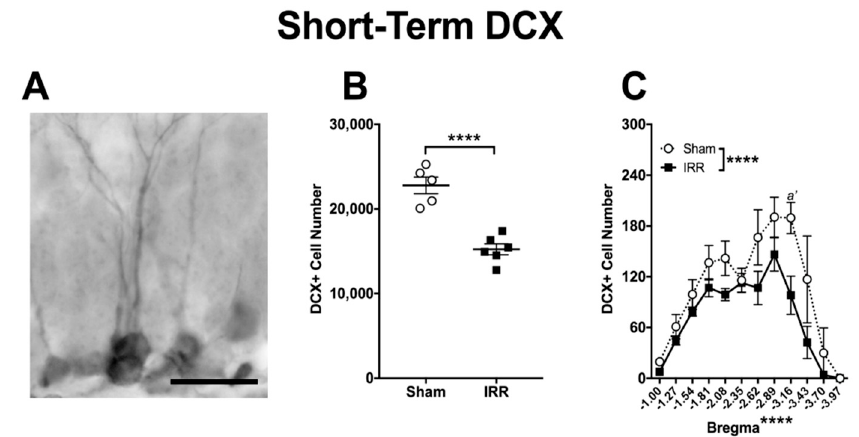
Figure 5. 24-h post-irradiation, whole-body exposure to 12 C irradiation reduced the number of DG GCL DCX+ cells relative to Sham treatment. ( A ) Representative photomicrograph of DCX staining in a Short-Term Sham mouse (mouse #14088; 400 × , scale bar = 25 µ m). ( B ) An unpaired t -test revealed fewer DCX+ cells in IRR versus Sham mice (**** p < 0.0001; N = 5 Sham, N = 6 IRR). ( C ) Bregma analysis of DCX+ cells through two-way repeated measure ANOVA (Bregma × Treatment) revealed main effects of Treatment ( F 1,9 = 43.53; **** p < 0.0001) and Bregma ( F 11,99 = 17.49; **** p < 0.0001), but no significant interaction (F 11,99 = 1.139; p > 0.05). Post-hoc (Sidak’s multiple comparison) test revealed fewer DCX+ cells at bregma − 3.16 in IRR versus Sham mice ( a’ p < 0.01). Error bars ± SEM.